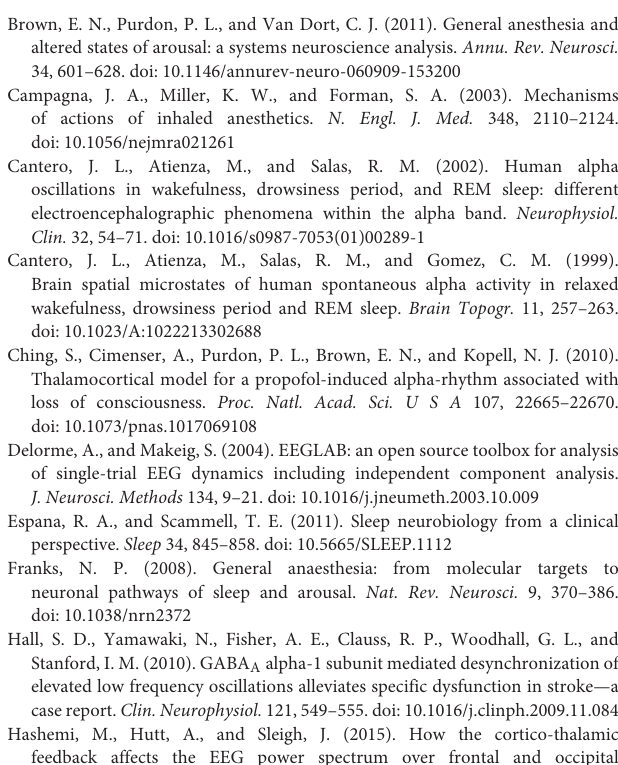
FIGURE S1 | Overlay of subject level spectra for baseline awake, sevoflurane effect-onset no response and sevoflurane general anesthesia (GA). These spectra illustrate that awake-alpha power in the sevoflurane effect-onset no-response spectra were decreased compared to baseline-awake spectra. Additionally, sevoflurane-GA spectra were associated with larger slow-delta oscillation power compared to the baseline-awake and sevoflurane effect-onset no response spectra. Sevoflurane-GA spectra were also associated with decreased gamma oscillation power compared to the baseline-awake